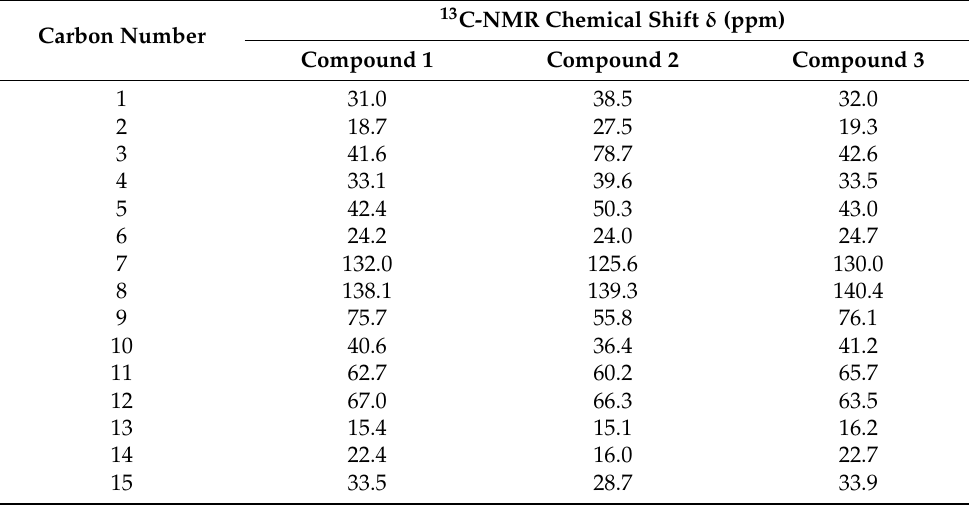
Table 3. 13 C-NMR results of the biotransformation products 1 to 3 . Data were acquired at 101 MHz in acetone-d 6 . Chemical shifts ( δ ) are reported in ppm. Carbon numbering is provided in Scheme 1.